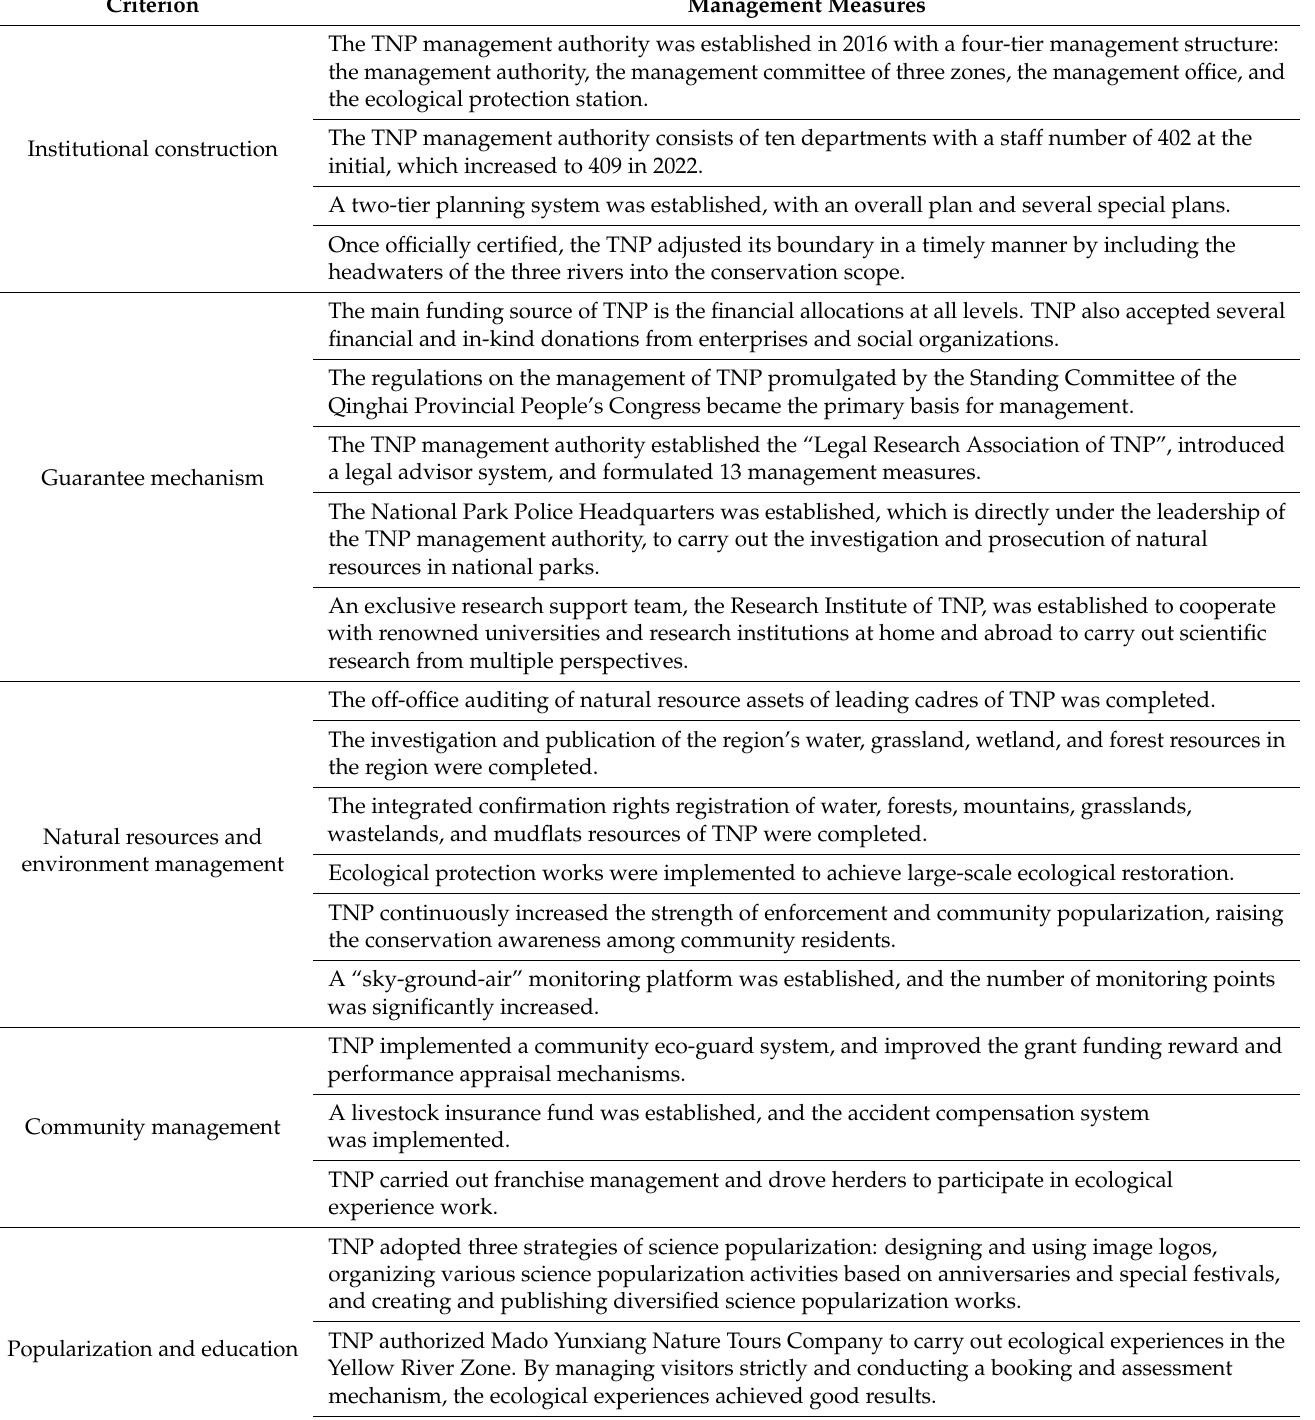
Table 4. Management measures adopted by TNP during the pilot